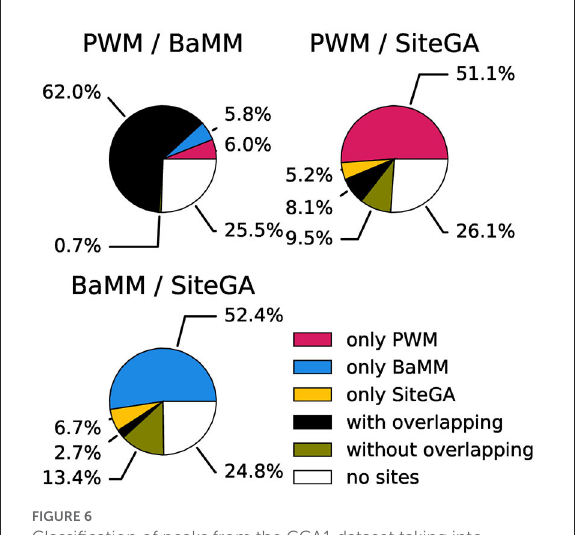
FIGURE6 Classification of peaks from the CCA1 dataset taking into account the presence of the BSs and the overlaps of their positions. Three pie charts show pairwise combinations of PWM/BaMM, PWM/SiteGA, and BaMM/SiteGA models. Red, blue, and yellow sectors mark the fractions of peaks recognized by only one model in pairs (PWM, BaMM, and SiteGA, respectively). Black/olive sectors denote the fractions of peaks recognized by two models with/without overlapping hits. The white color means that the hits of both models are absent. The analysis was performed with the medium thresholds (recognition scores respecting ERR 6